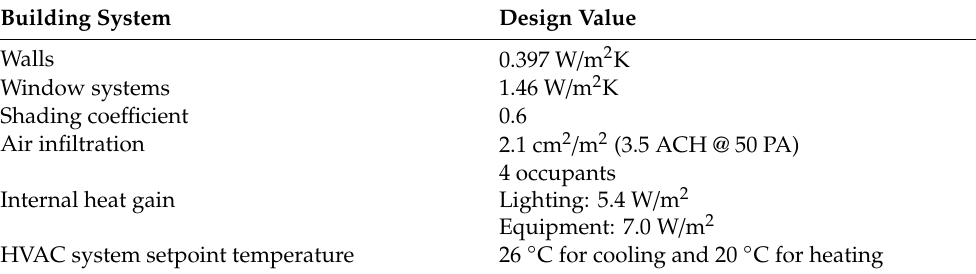
Figure 1. The plan of the selected unit of the reference residential building. Table 1. The specification for the energy simulation .